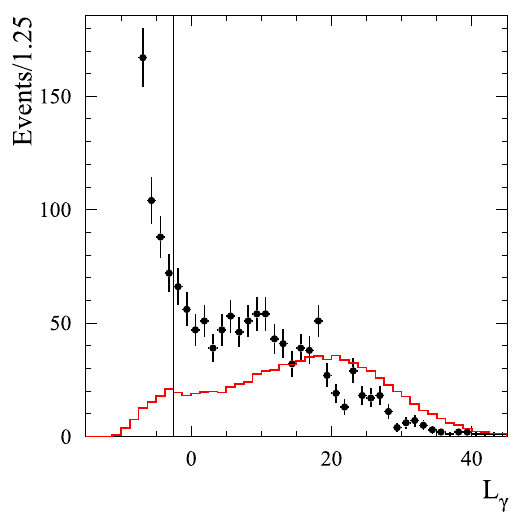
Fig. 3 The L γ distribution for 2019 data events with E b = 945, 950, 951 MeV (points with error bars). Events satisfy the standard selection criteria except for the condition on L γ . The histogram represents the same distribution for simulated signal events. The vertical line indicates the boundary of the condition L γ > − 2 .